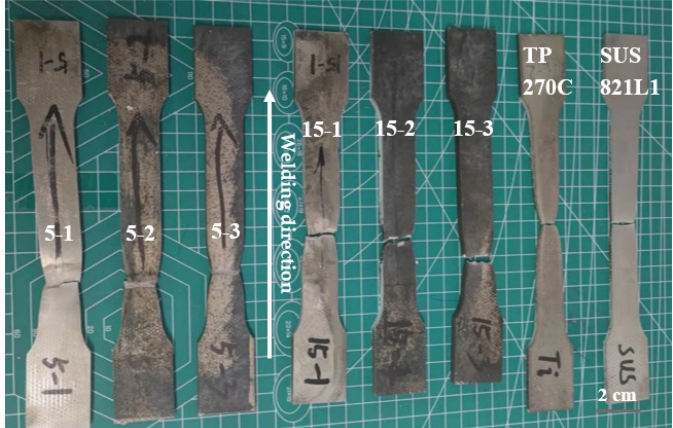
Figure 5. Samples after stretching.